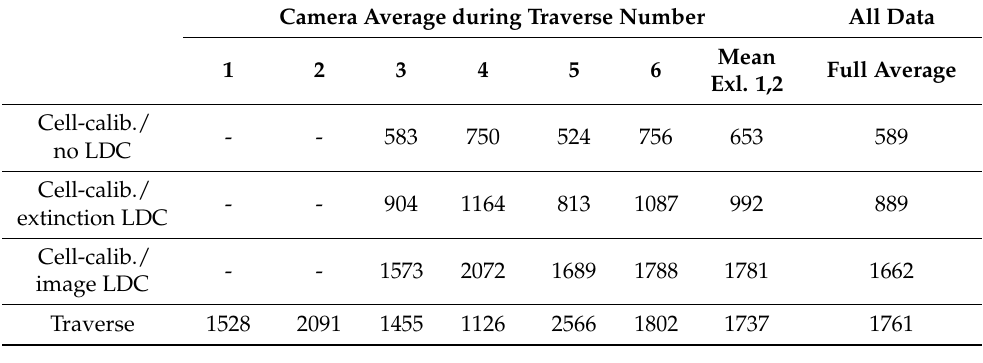
Table 2. Average SO 2 emission rates (in metric tons/day) as measured by camera methodologies, with different light dilution corrections (LDC) and traverses for 10 January 2018 for each traverse time interval. An overall average for all measurements from the day is also included.